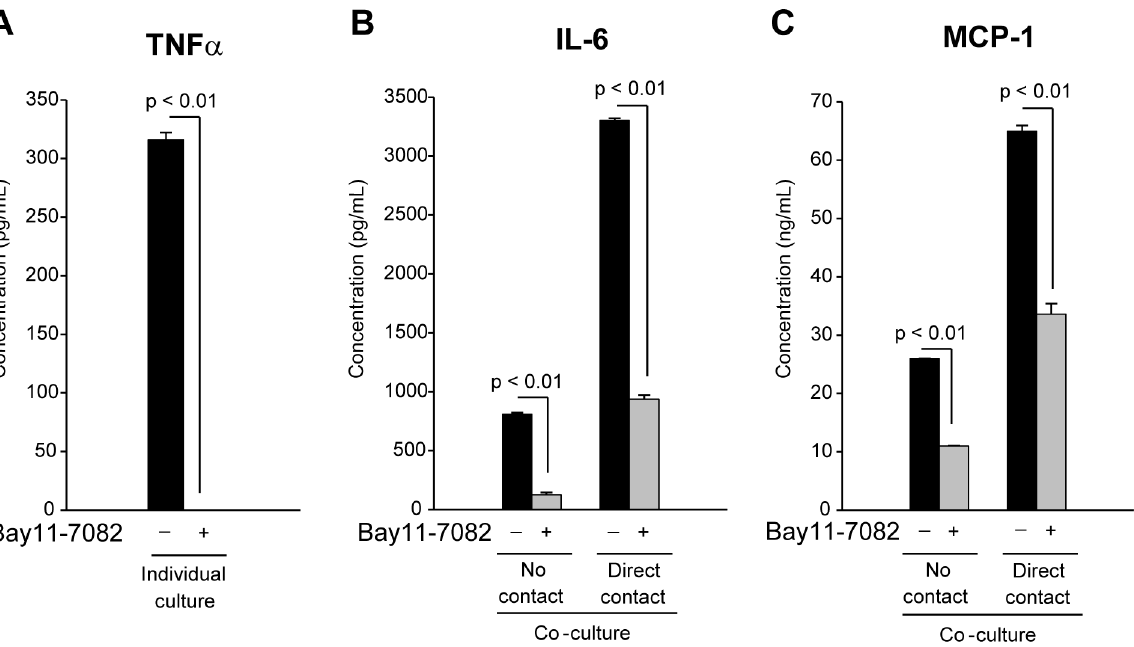
Figure 6. NF- k B intracellular signaling pathway participates in the paracrine and cell contact-mediated enhancement of IL-6 and MCP-1 secretion. (A) Isolated splenocytes were incubated with LPS (1 m g/mL) in the absence (-) or presence ( + ) of 2 m M Bay11-7082 for 24 h. Secreted levels of TNF a were measured by capture ELISA. (B and C) Differentiated 3T3-L1 adipocytes were co-cultured with isolated splenocytes with either no contact or direct contact as indicated. Cells were stimulated with LPS (1 m g/mL) in the absence ( 2 ) or presence ( + ) of 2 m M Bay11-7082 for 24 h. Secreted levels of IL-6 (B) or MCP-1 (C) were measured by capture ELISA. All experimental points were measured in triplicate for calculation of means and standard deviations. In (A) an unpaired two-tailed Student’s t test was used to compare Bay11-7082 treated and untreated LPS-stimulated splenocytes. Comparisons between co-cultures (B and C) were calculated using ANOVA followed by the post-hoc Bonferroni test.